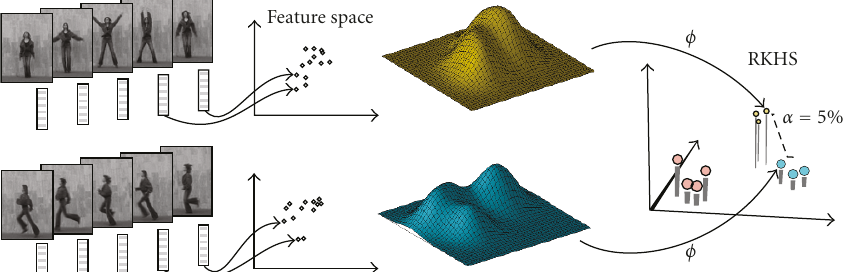
Figure 1: Unsupervised action recognition is performed by computing a feature vector for each frame of the sequence (left), as described in Section 6. A nonparametric probability distribution on the feature space is computed for each sequence (center); di ff erent sequences are compared by mapping the corresponding probability distributions to an RKHS by means of φ (right): in particular, sequences representing the same actions are clustered by using MMD as a distance metric.